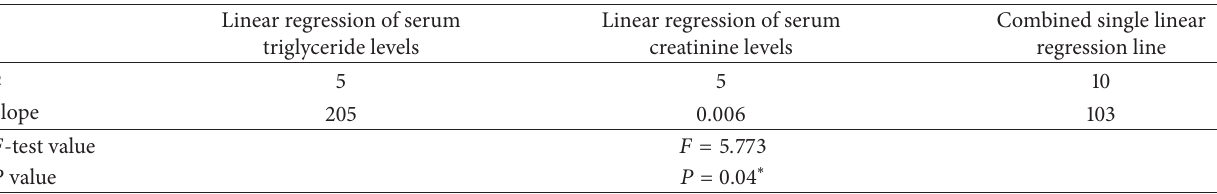
Table 3: Results: overall test for the coincidence of the correlation of increases in serum triglyceride and creatinine levels over propofol infusion